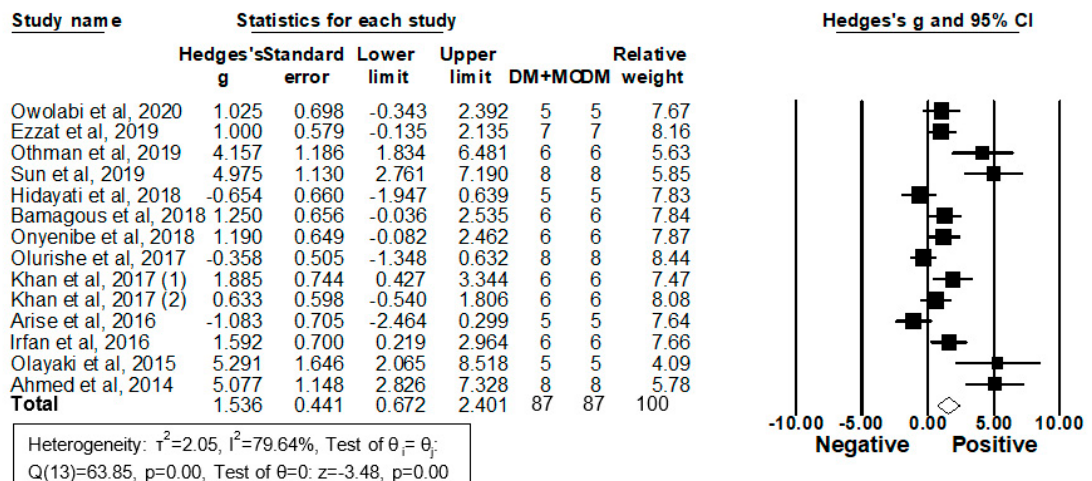
Figure 7. Meta-analysis of Hedges’ g of HDL-C levels in DM rodents with and without treatment with MO. Summary estimates were analyzed using a random-effects model. CI, confidence interval.